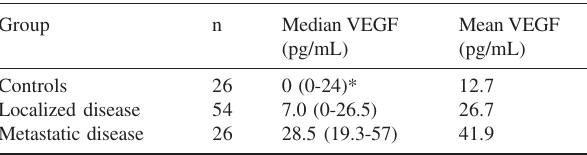
Table 1 - Plasma vascular endothelial growth factor (VEGF) concentrations in the 3 groups analyzed